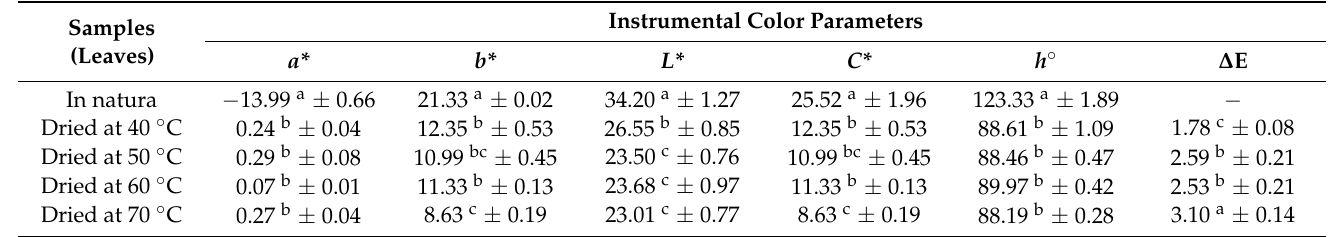
Table 3. Instrumental color parameters for purple basil in natura and dried at different temperatures.